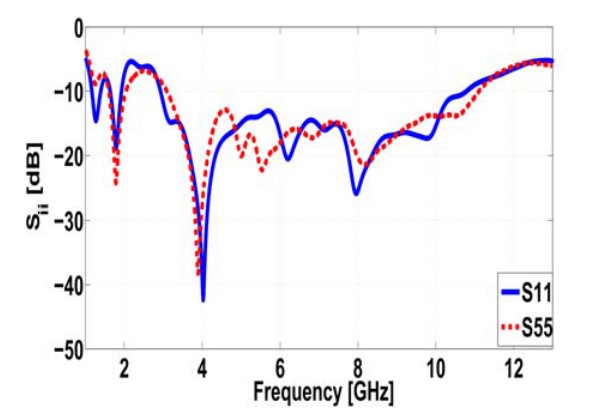
FIGURE.4 Reflection coefficients comparison with and without the defected microstrip structure (DMS)